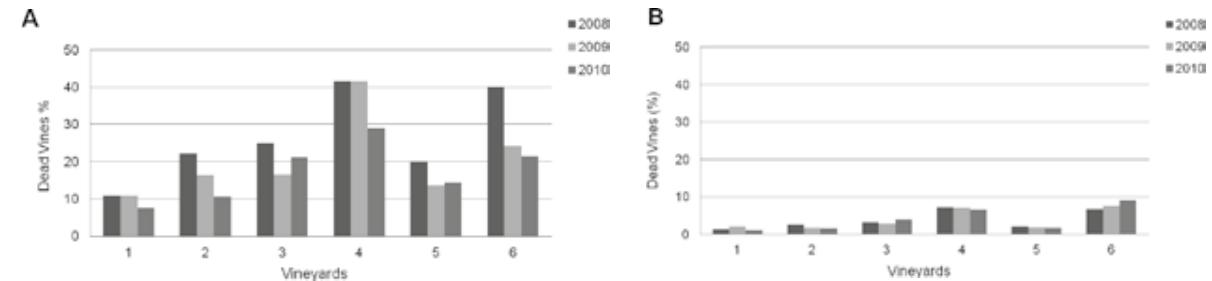
Figure 2. Percentage of dead vines in 2008, 2009 and 2010 among vines either expressing esca symptoms previously (A), or among asymptomatic vines previously (b), in all six vineyards.